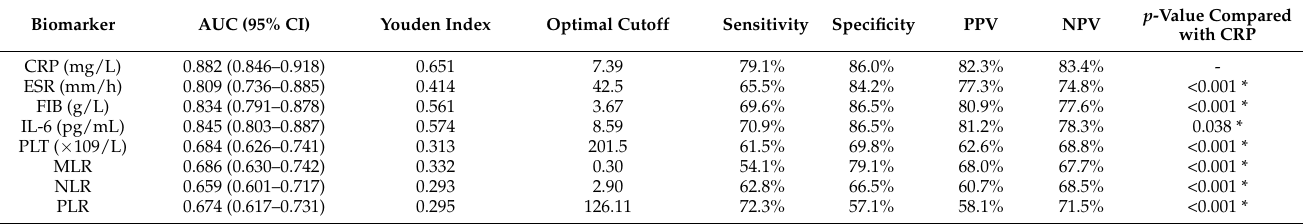
Table 3. Diagnostic performance of the tested biomarkers individually.